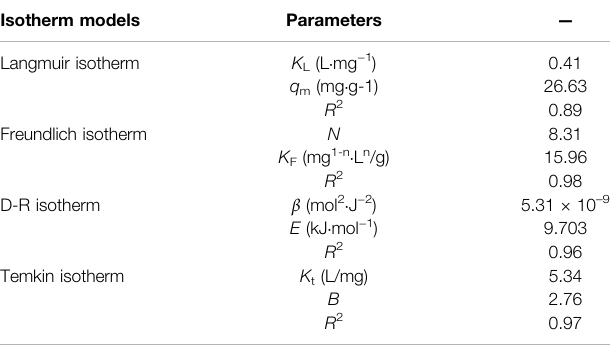
TABLE 3 | Isotherm parameters of PMBN3 adsorption towards Sr(II). Isotherm models Parameters — Langmuir